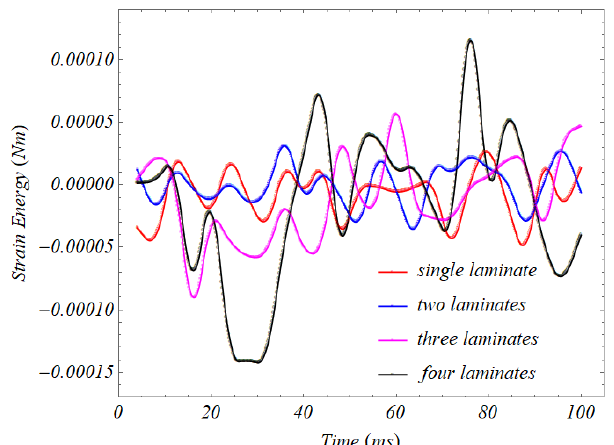
Fig. 7. Strain energy against time for various number of cellphone casing laminates at 500mm drop distance.